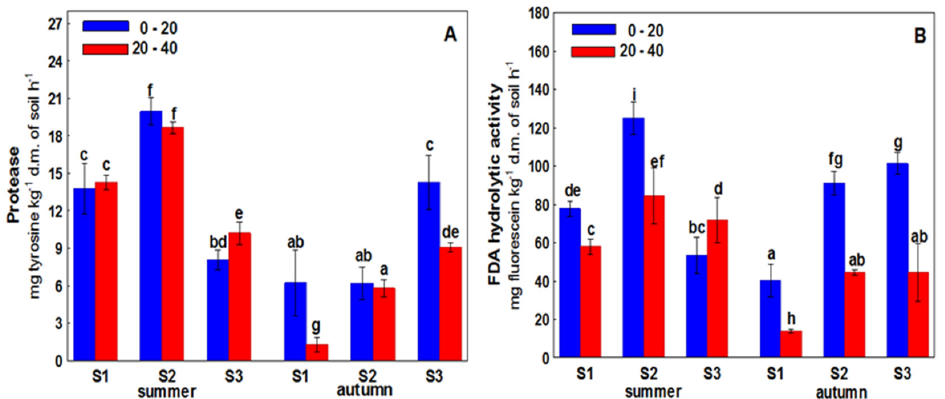
Figure 4. Enzymatic activity in soil from 0–20 and 20–40 cm depths continued: ( A ) protease; ( B ) FDA hydrolytic activity. Legend: S1, S2, S3—sampling sites located S1—5.88, S2—22.7 and S3—50.08 m from the reservoir with liquid post-production waste. Vertical lines indicate the standard deviation. Different letters above the columns indicate significant differences at p < 0.05.